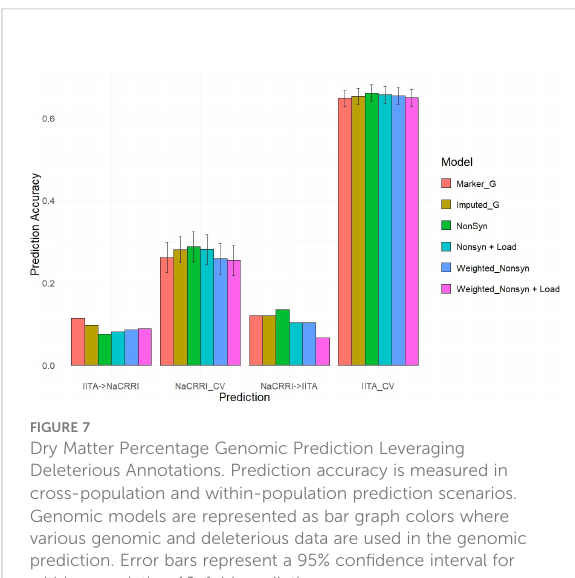
FIGURE 7 Dry Matter Percentage Genomic Prediction Leveraging Deleterious Annotations. Prediction accuracy is measured in cross-population and within-population prediction scenarios. Genomic models are represented as bar graph colors where various genomic and deleterious data are used in the genomic prediction. Error bars represent a 95% con fi dence interval for within-population 10-fold prediction.